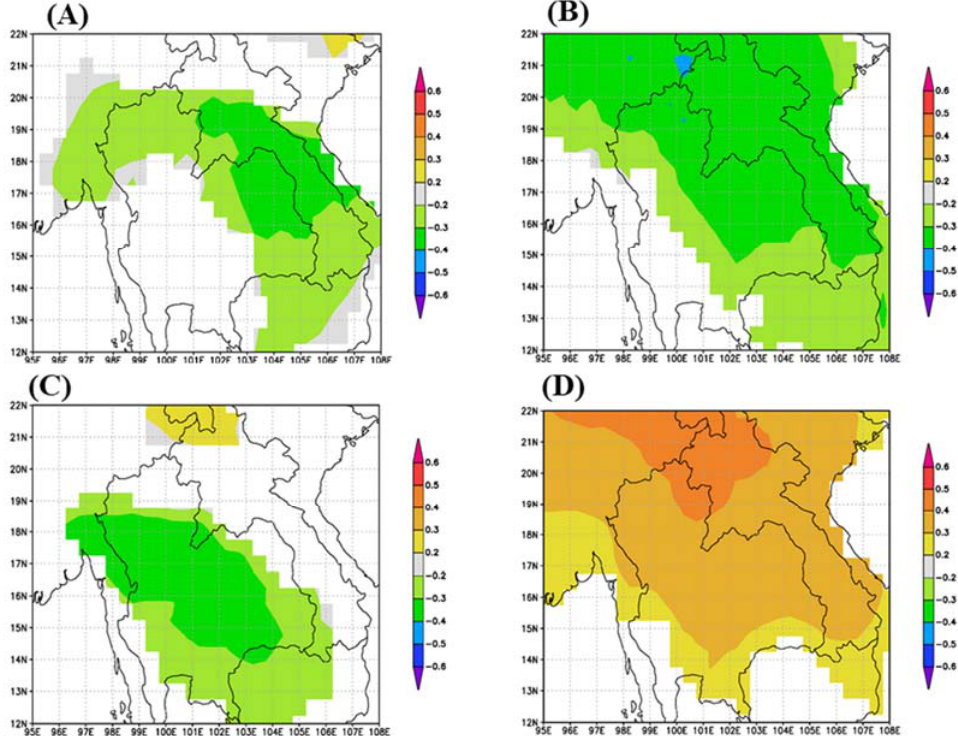
Figure 7. ( A ) Correlation of tree ‐ ring δ 13 C with July–September averaged CRU TS4.04 precipitation 1901–2009, p < 10%; ( B ) correlation between tree ‐ ring δ 13 C with June–August averaged CRU TS4.04 potential evaporation 1901–2009, p < 10%; ( C ) correlation between tree ‐ ring δ 13 C with August–Oc ‐ tober averaged CRU TS4.04 vapor pressure1901–2009, p < 10%; ( D ) correlation tree ‐ ring δ 13 C